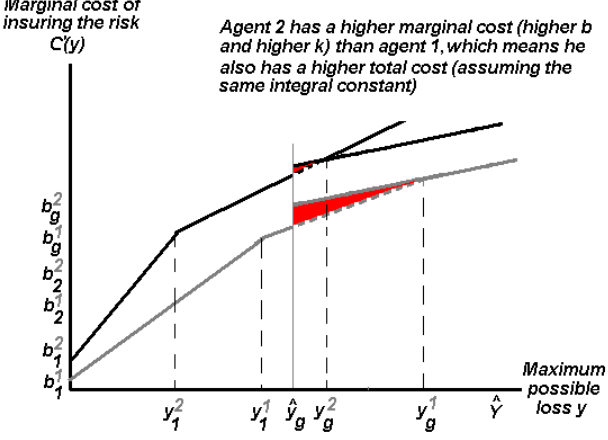
Fig. 6. Gain and loss from government intervention. Fig. 7. Government intervention by fixing its attachment point be- low y 2 g .